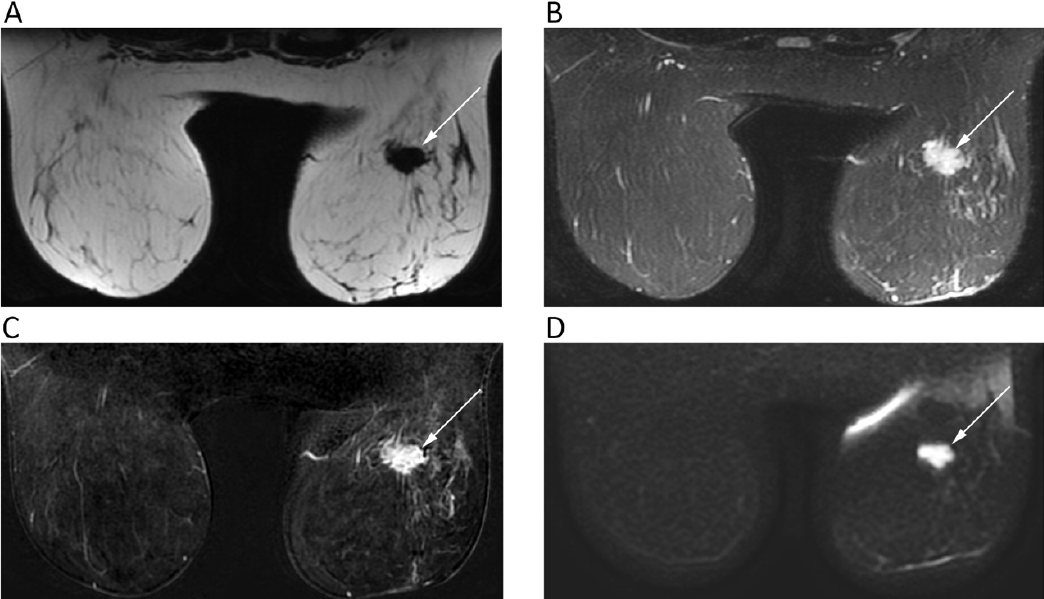
Figure 4. Breast MRI of a 42-year-old female patient with right breast carcinoma. Axial IDEAL fat only ( A ) and IDEAL water only ( B ) images show a right breast carcinoma (arrows) with strong enhancement on post-contrast T1w image ( C ) and high signal intensity on b = 900 DWI image ( D ).